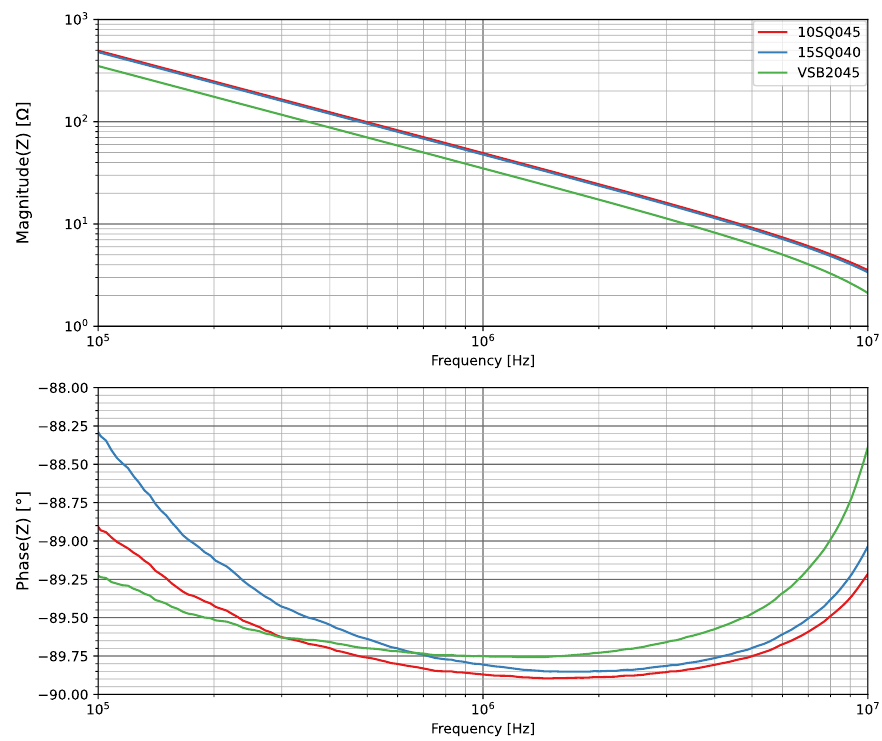
Figure 27. Measured unbiased AC small-signal impedance plots for the three diodes between 100kHz and